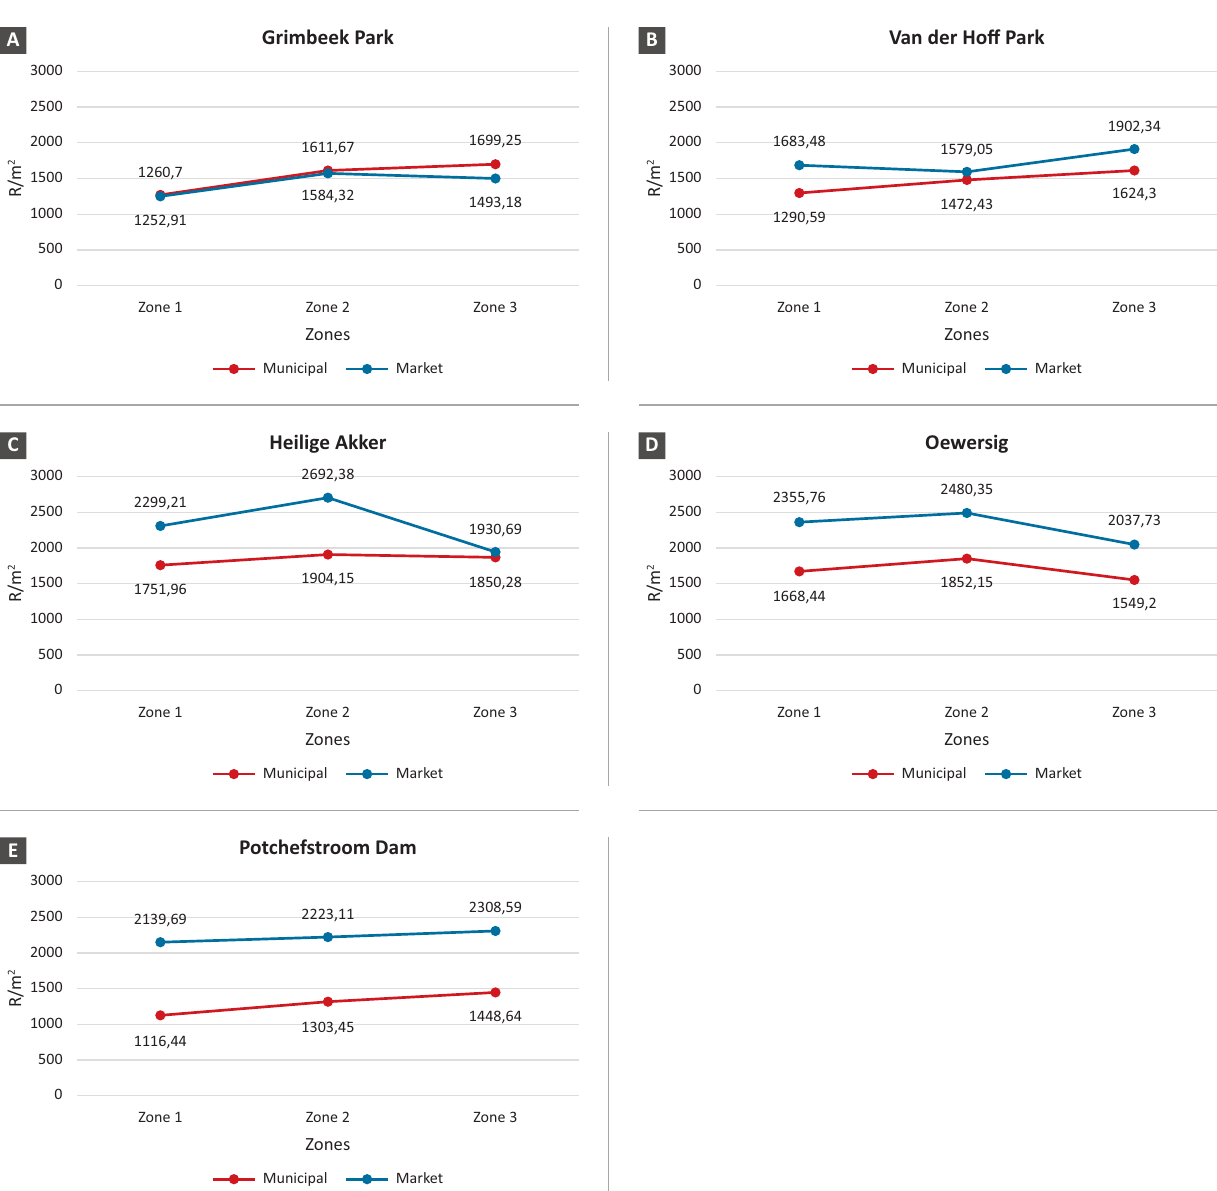
Figure 1. Mean South African Rand/m 2 municipal valuation and estimated market values for the Potchefstroom